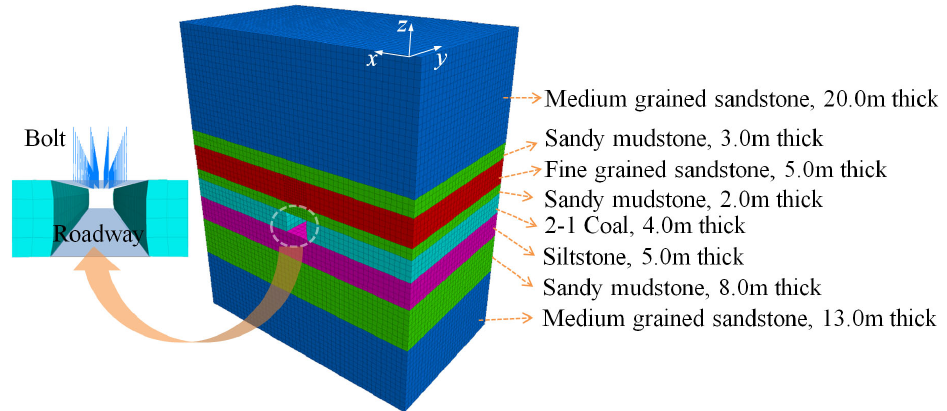
Figure 4. Modeling. Figure 4.